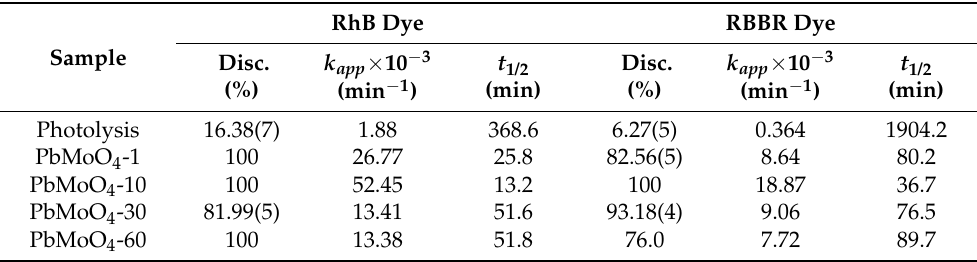
Table 2. Discoloration ratio (%), apparent kinetic rate constant ( k app ) and half-life time ( t 1/2 ) obtained from photocatalysis assay of RhB and RBBR with photolysis and PbMoO 4 nanocrystals. RhB Dye RBBR Dye Sample Disc.